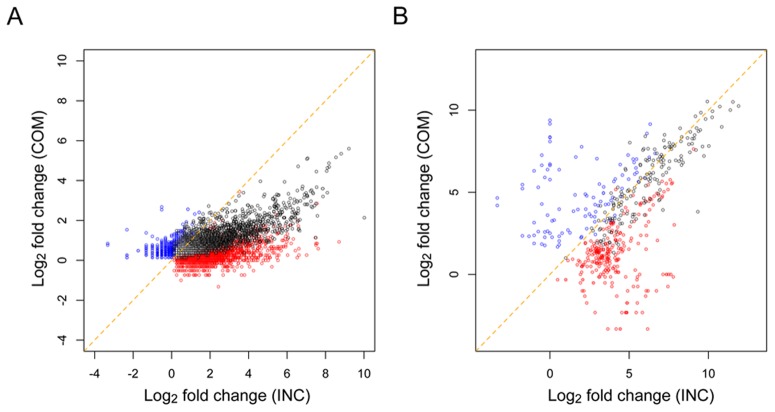
Distribution of fold-changes of rice and fungal significantly upregulated transcripts.The fold-changes (log2) of the significantly upregulated transcripts in the compatible and incompatible interactions are plotted for (A) rice and (B) blast fungus. The colors represent the types of interactions in which the upregulations occurred (black: Common, blue: COM-specific, red: INC-specific).